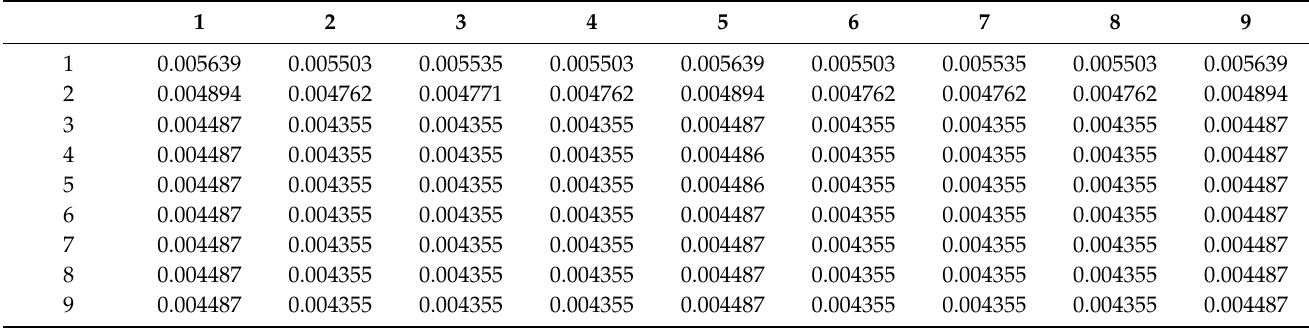
Table 2. Power value (Watts) of each aperture (Y axis, δ = − 2°, θ = − 0.5°).